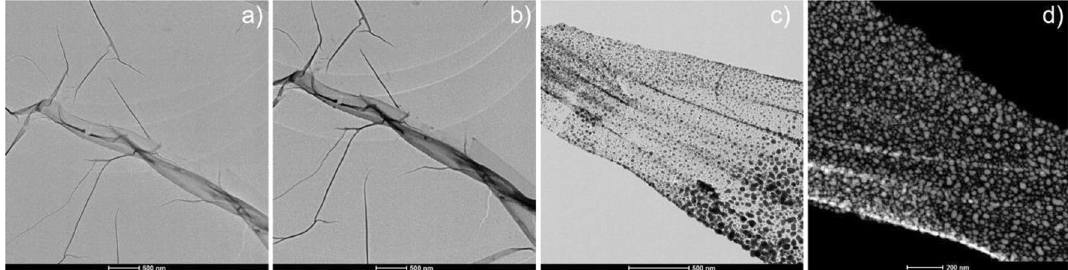
Figure 9. Thermal effect on the 2D printed structures. TEM micrographs of the nano sheet during the In-situ annealing: ( a ) at 60 °C, ( b ) at 200 °C, ( c ) at 400 C, ( d ) STEM HAADF at 550 °C.